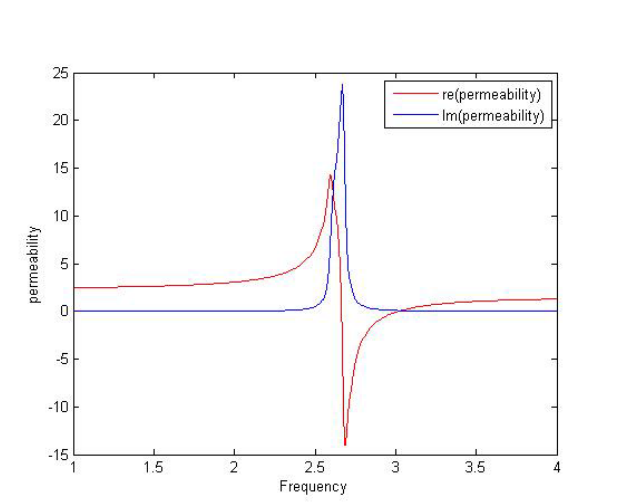
Figure 5: Permeability of unit cell